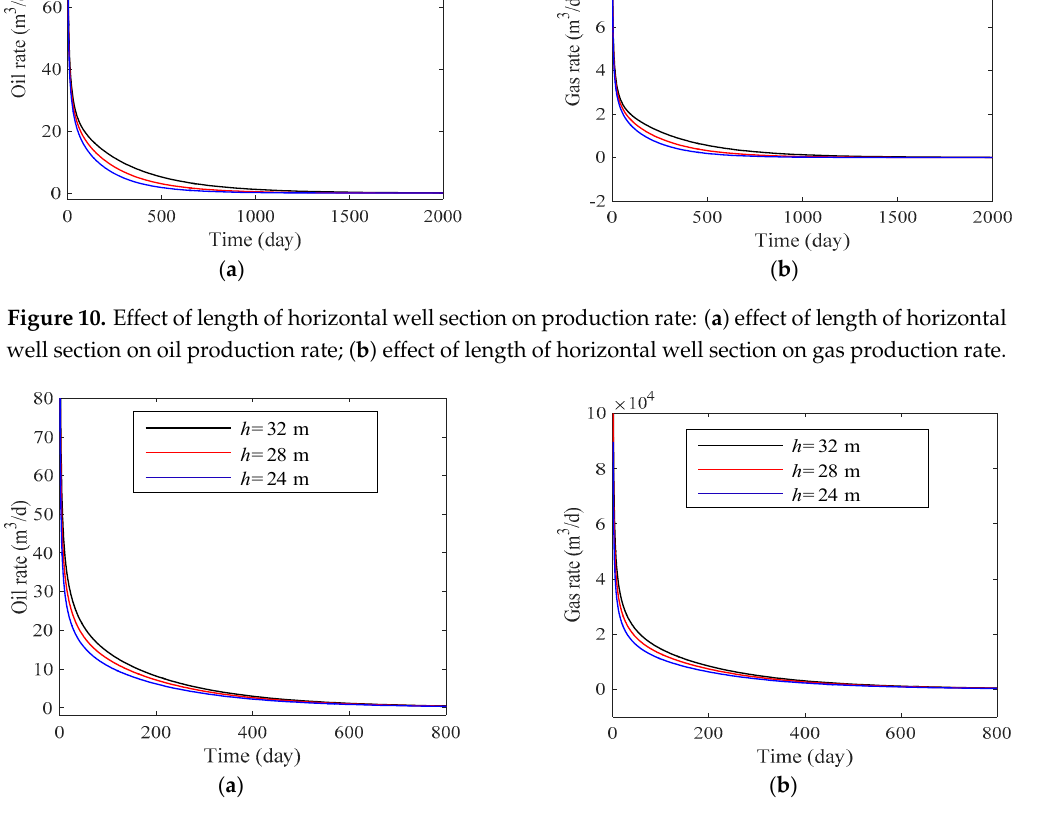
Figure 11. Effect of reservoir thickness on production rate: ( a ) effect of reservoir thickness on oil production rate; ( b ) effect of reservoir thickness on gas production rate.